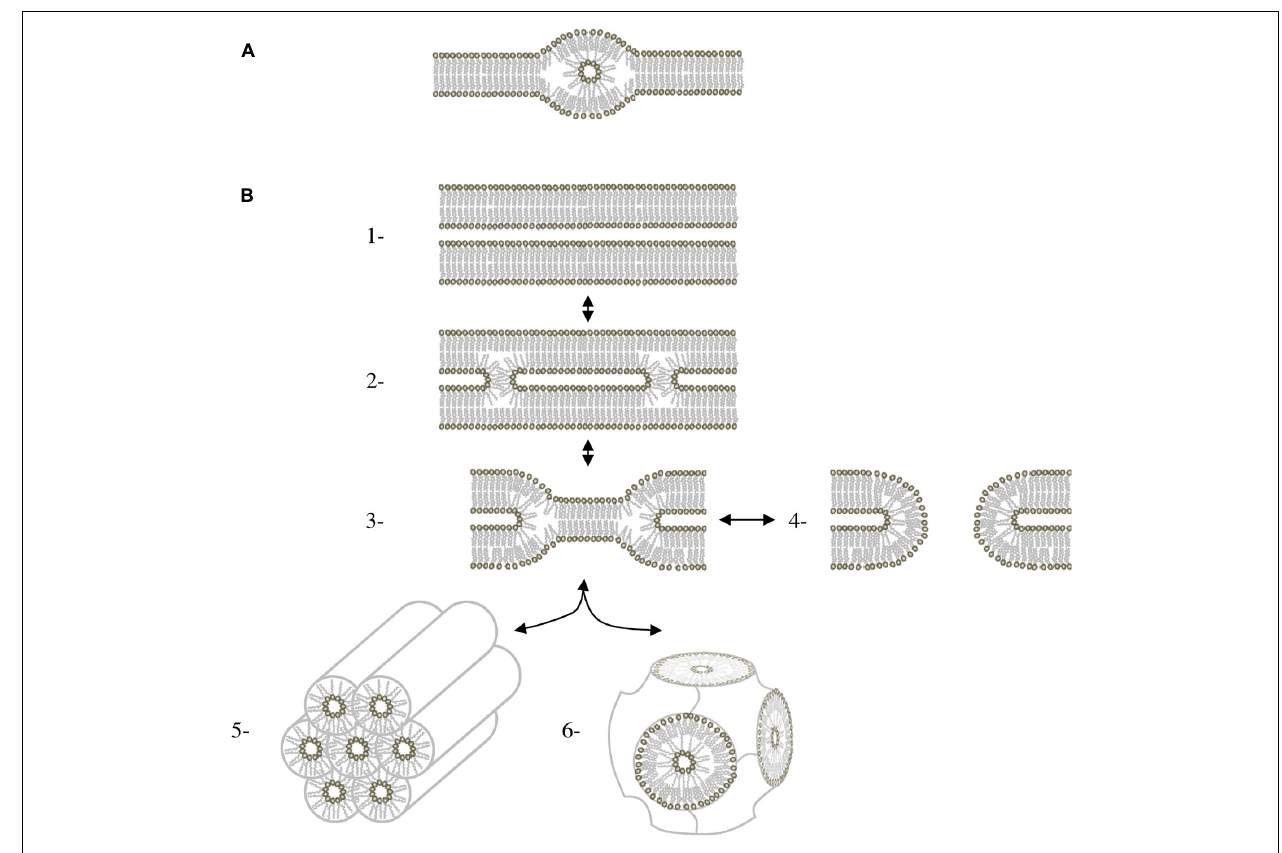
hemifusion intermediate ruptures, it forms a fusion pore (4) If fusion pores accumulate in sufficient numbers, they can rearrange to form a cubic phase (5) For systems close to the lamellar/HII phase boundary, hemifusion intermediates can also aggregate to form HII phase (6) Figure adapted from Siegel